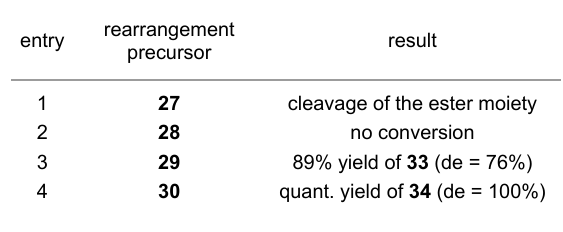
Table 1: Ireland–Claisen rearrangement of model compounds 27 , 28 , 29 and 30 .